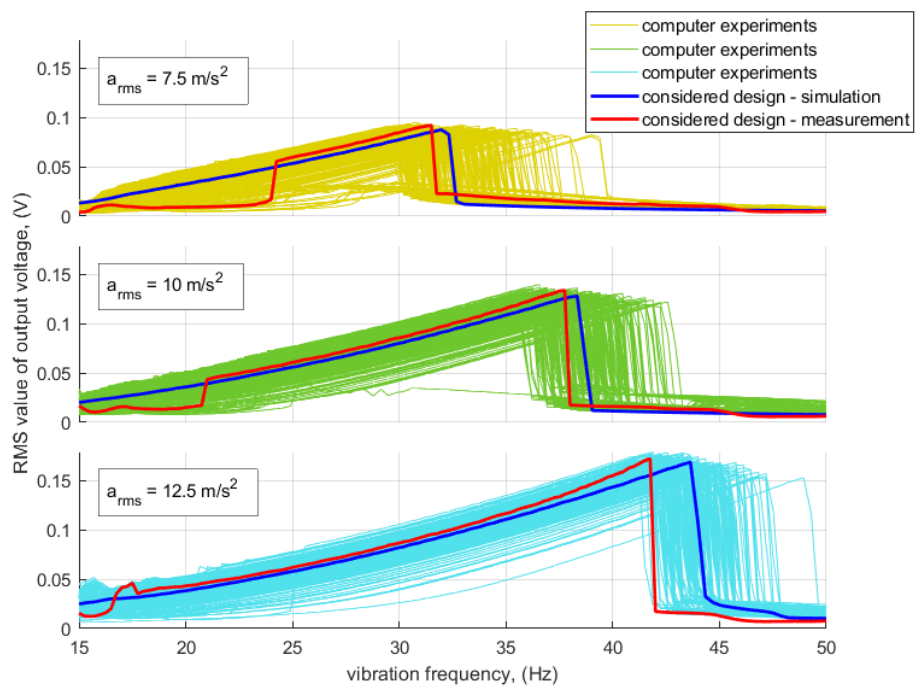
Figure 9. RMS values of output voltage vs. frequency for training points computed from full model for different RMS values of vibration accelerations.